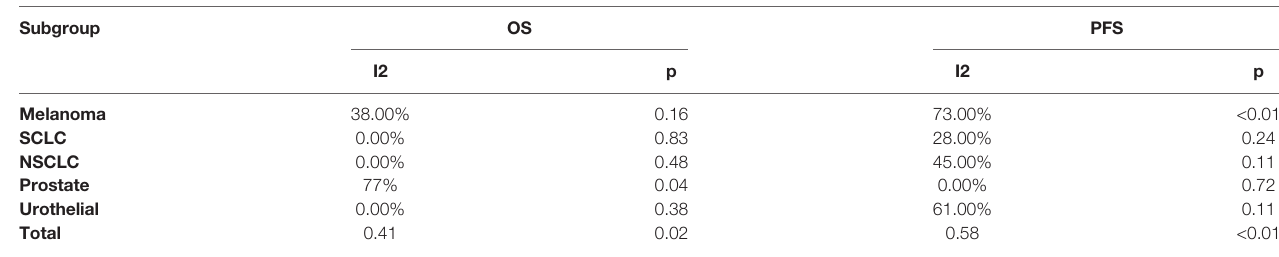
TABLE 1 | The primary characteristics of the 23 articles.